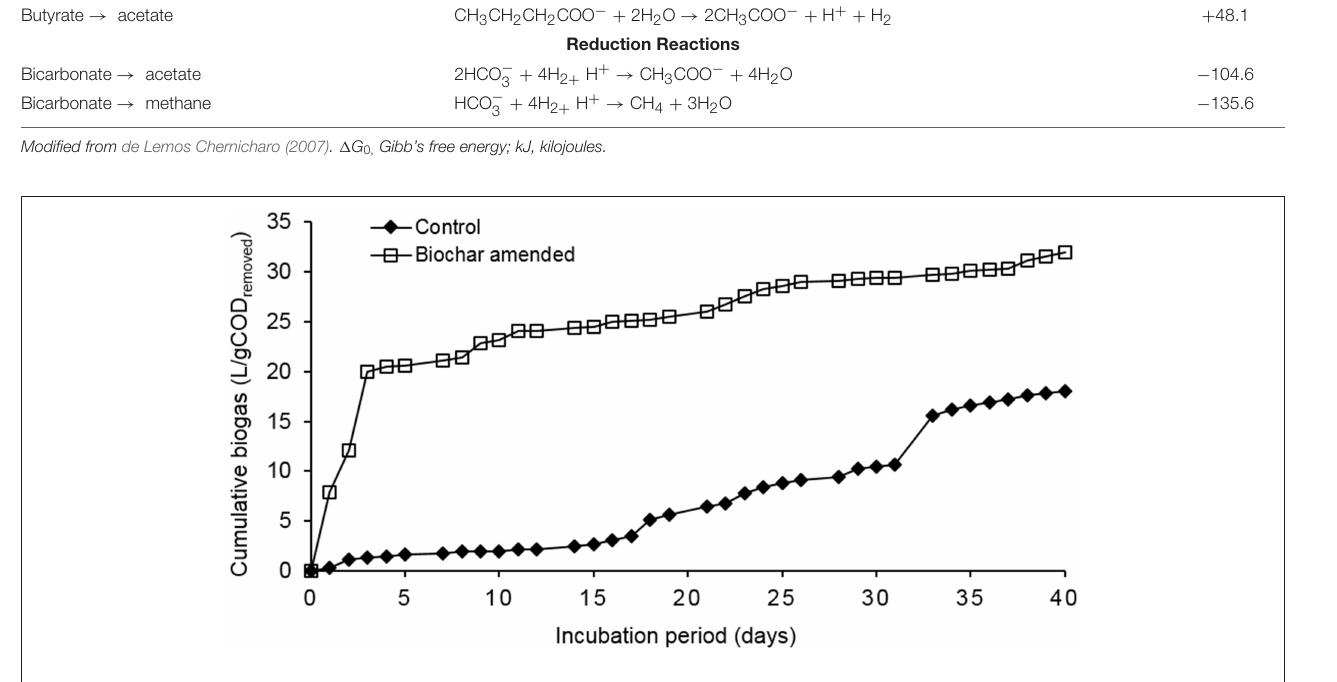
FIGURE 6 | Cumulative biogas production in the control and biochar amended UASB